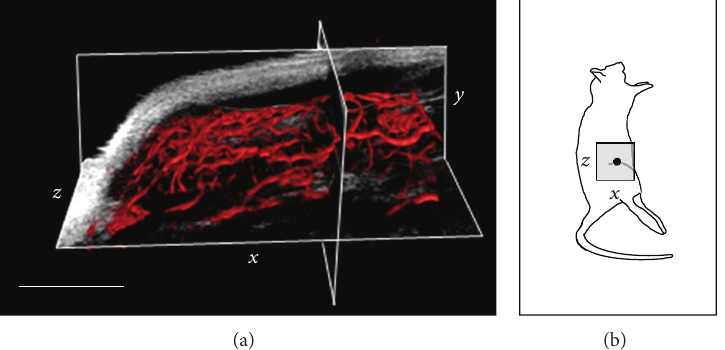
Figure 5: (a) An overlay of the microvasculature within a tumor provided by acoustic angiography (red) onto a tissue-only image provided by high frequency b-mode (grayscale). This figure was created using 3D slicer (National Institutes of Health) with a 3D rendering of the acoustic angiography data simultaneously displayed with a grayscale orthoslice of the b-mode data. Displaying data in this fashion illustrates microvessel and tissue morphologies, as well as vascular-tissue integration. Scale bar = 0.5cm. (b) A cartoon illustrates the approximate location of this 3D image volume.